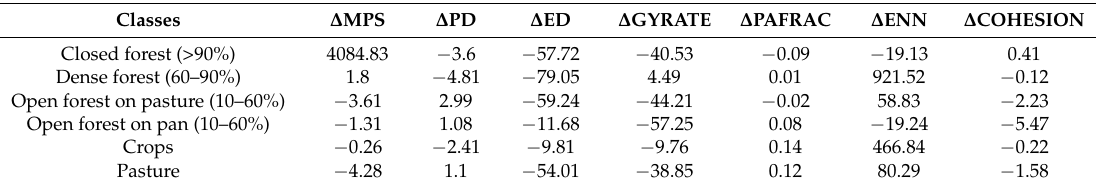
Table 6. MPS, PD, ED, GYRATE, PAFRAC, ENN, and COHESION changes experienced by different land use and cover types between 1957 and